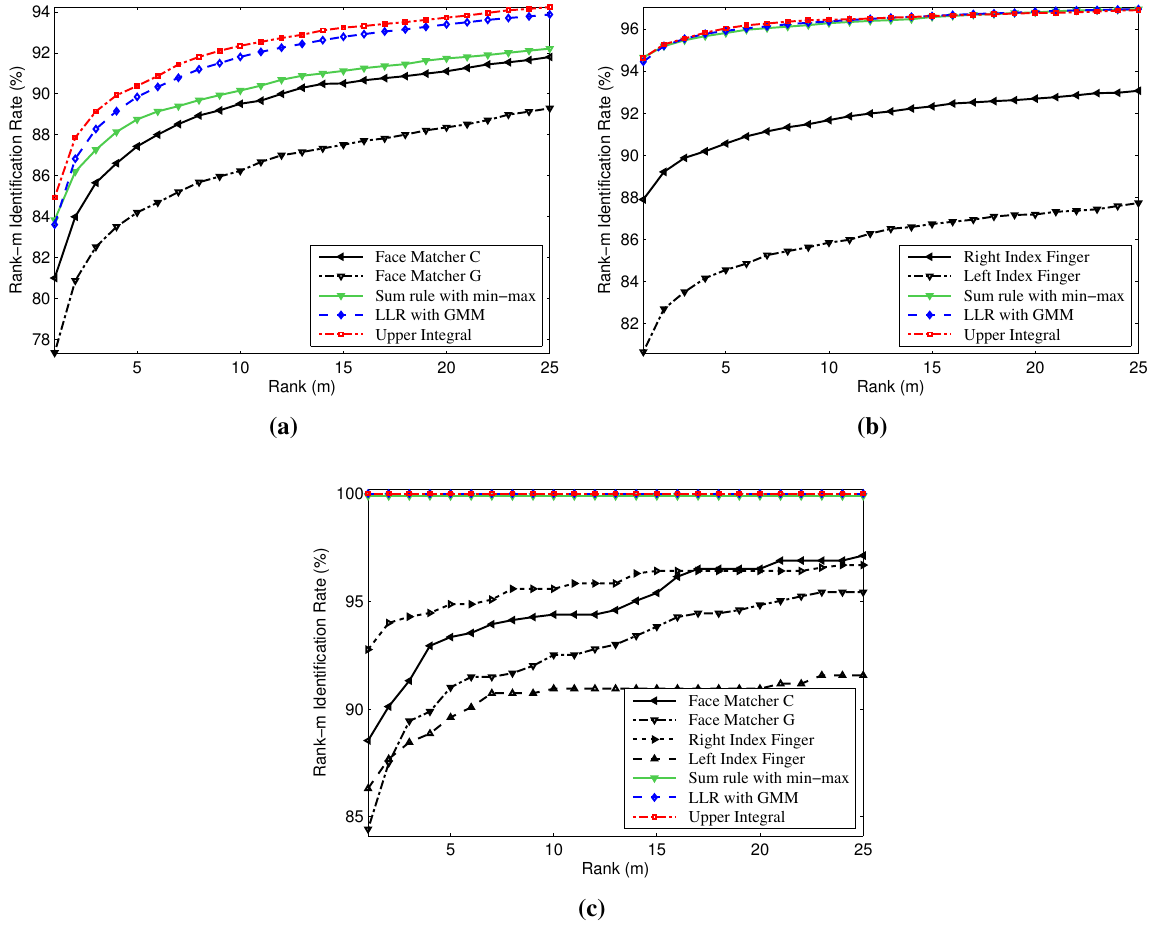
Figure 1. Cumulative match characteristic curves of the proposed method, individual matchers and other biometric score fusion methods on the ( a ) NIST-Face, ( b ) NIST-Fingerprint and ( c ) NIST-Multimodal